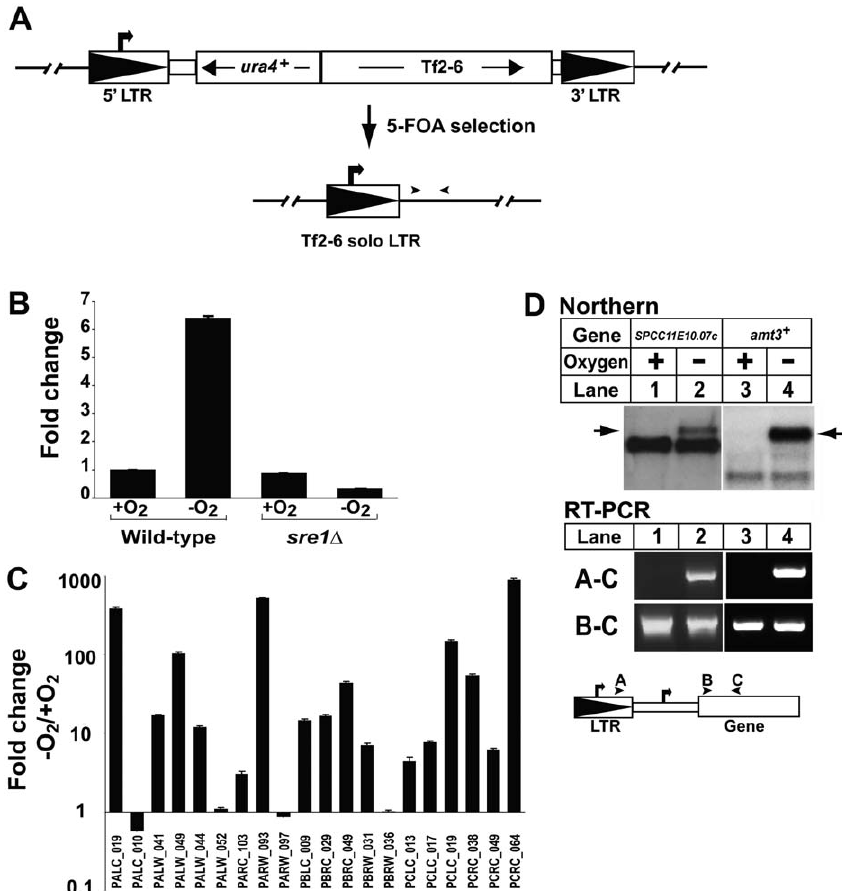
Figure 5. Endogenous Solo LTRs Function as Oxygen-Dependent Promoters (A) Scheme for generating Tf2–6 solo LTR. Recombination between intra-element LTRs yields solo LTR. Arrowheads denote position of RT-PCR primers. (B) Wild-type and sre1 D yeast containing Tf2–6 solo LTR were cultured þ / (cid:2) oxygen for 4 h. Transcription downstream of the LTR was quantified by real- time RT-PCR and normalized to values for wild-type cells þ oxygen. Error bars denote standard deviation among three real-time RT-PCR replicates. (C) Wild-type yeast were cultured þ / (cid:2) oxygen for 4 h. Transcription of sequences ; 100 bp downstream of 20 different Tf2 solo LTRs was quantified by real-time RT-PCR as described in Materials and Methods. Fold change in transcription after shifting to low oxygen is shown. Error bars denote standard deviation among three real-time RT-PCR replicates. (D) Wild-type yeast were cultured þ / (cid:2) oxygen for 6 h. Upper panel: Northern analysis using SPCC11E10.07c and SPAC2E1P3.02c probes. Arrows indicate Tf2 LTR derived transcript. Lower panel: RT-PCR to detect transcripts originating either in Tf2 LTR (A–C) or the full mRNA transcripts (B–C). Bold arrows denote transcription initiation sites. Arrowheads denote primer positions.